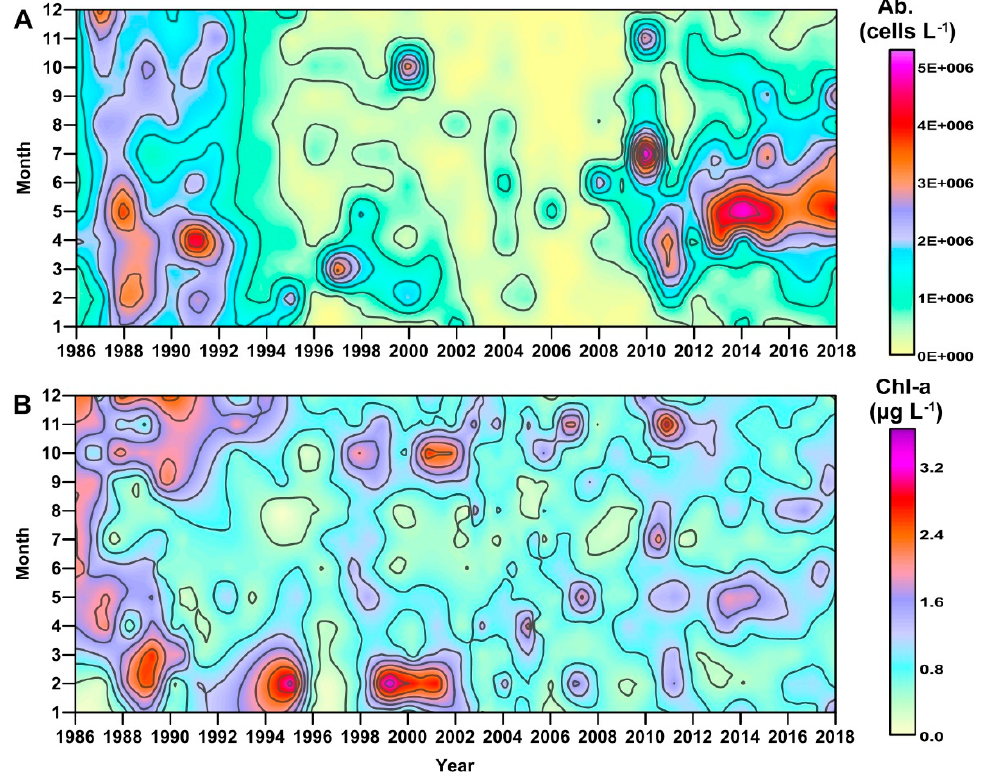
Figure 3. Depth-integrated values of monthly phytoplankton abundance (( A ); cells L − 1 ) and chlorophyll a concentration (( B ); µg L − 1 ) at the station C1, in 1986–2018. Water 2020 , 12 , x FOR PEER REVIEW